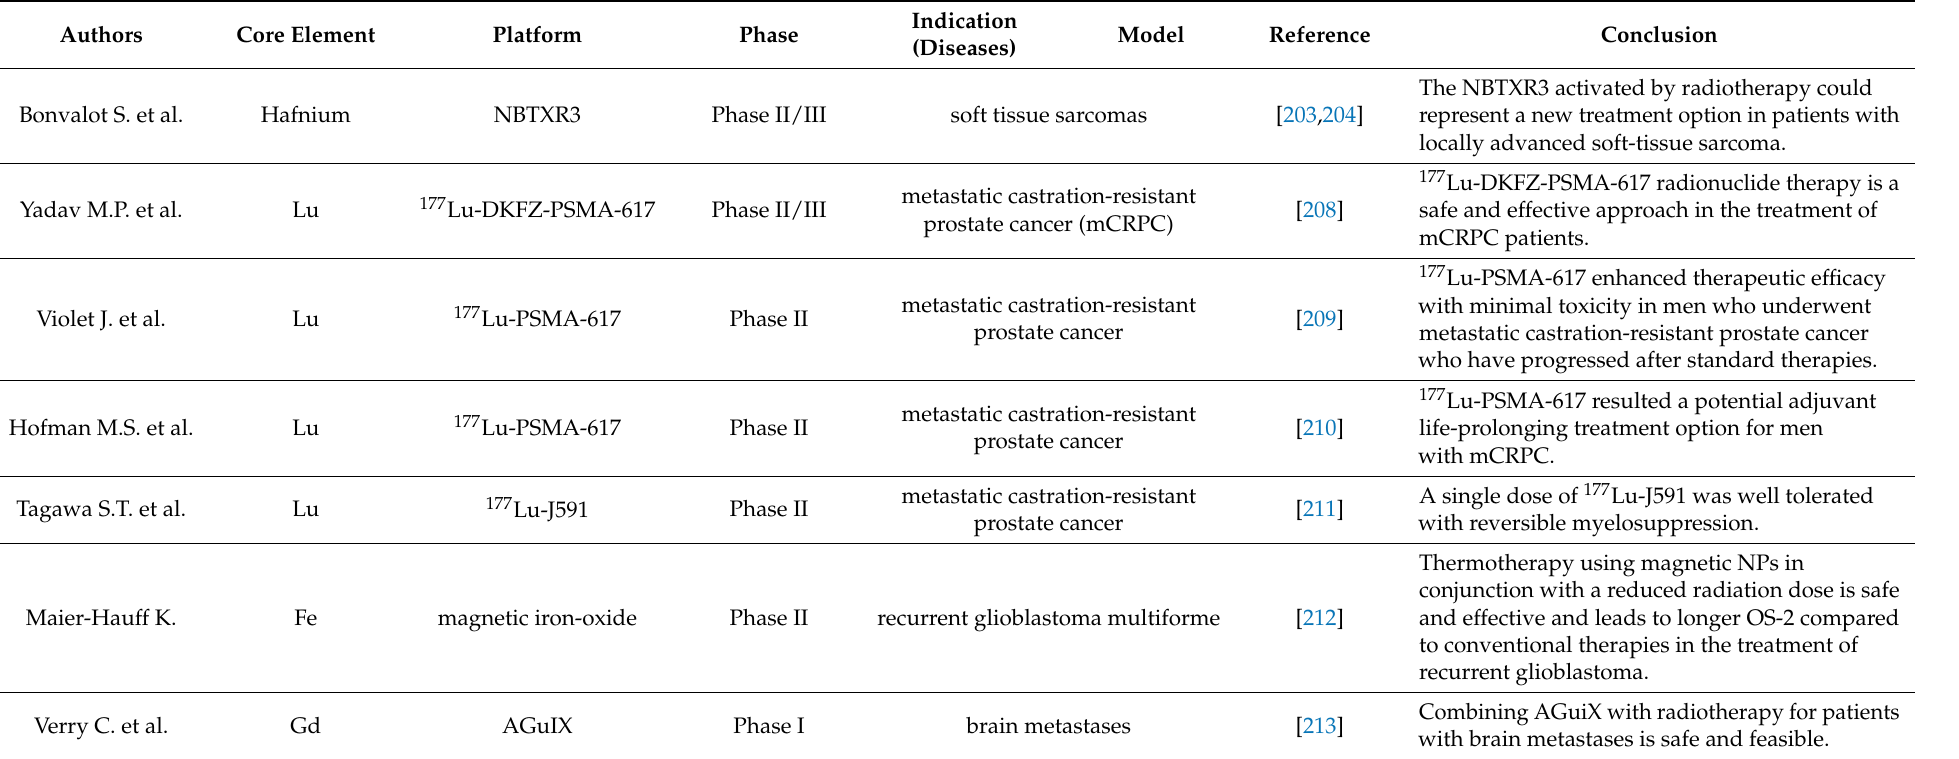
Table 3. Several studies describe the efficacy of high Z-metal elements in the form of nanoformulations for enhancing the efficacy of radiotherapy or brachytherapy in clinical trials. Fe: ferrous, Au: gold, Bi: bismuth, Lu: Lutetium, Hf: hafnium, Gd: